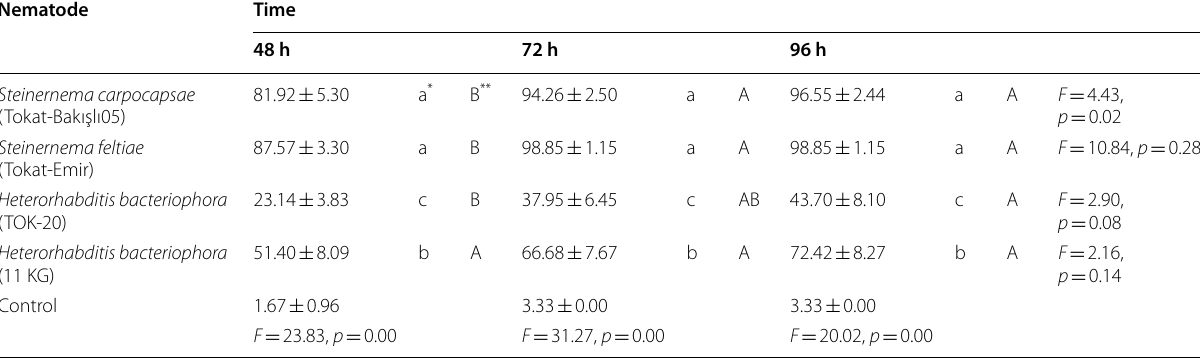
Table 7 The mortality rate of fourth stage cotton leafworm larvae at different exposure times